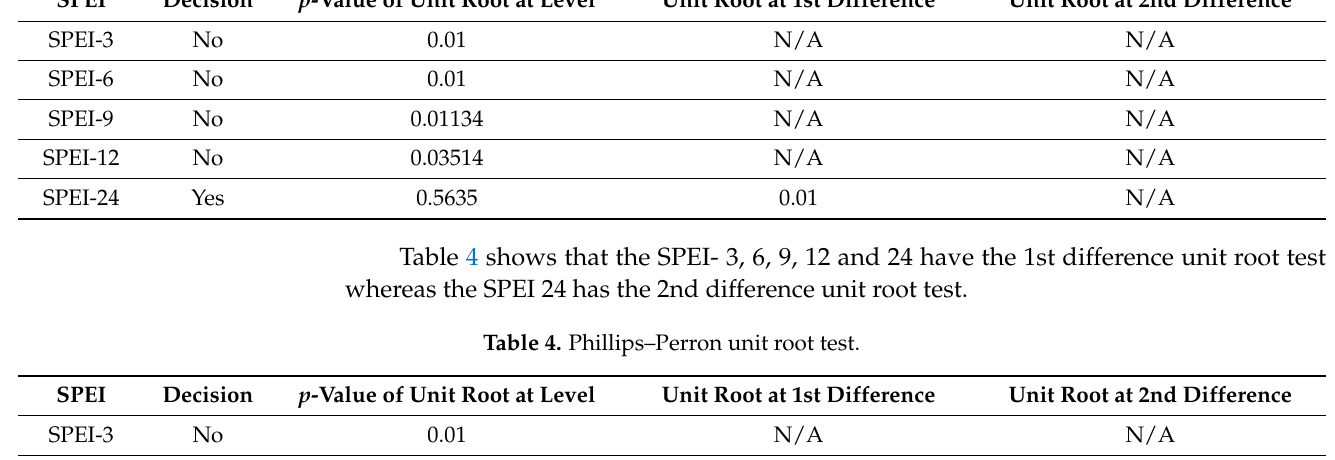
Figure 6. Annual cycle of the PET from 2004 to 2019 (Monthly variation). Unit Root Test